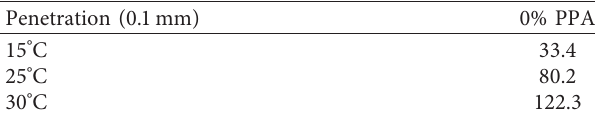
Figure 1: Effect of PPA content on conventional properties: (a) penetration at 25 ° C, (b) softening point, (c) 10 ° C ductility, and (d) viscosity at 135 ° C. Table 3: Penetration of PPA-modified asphalt.